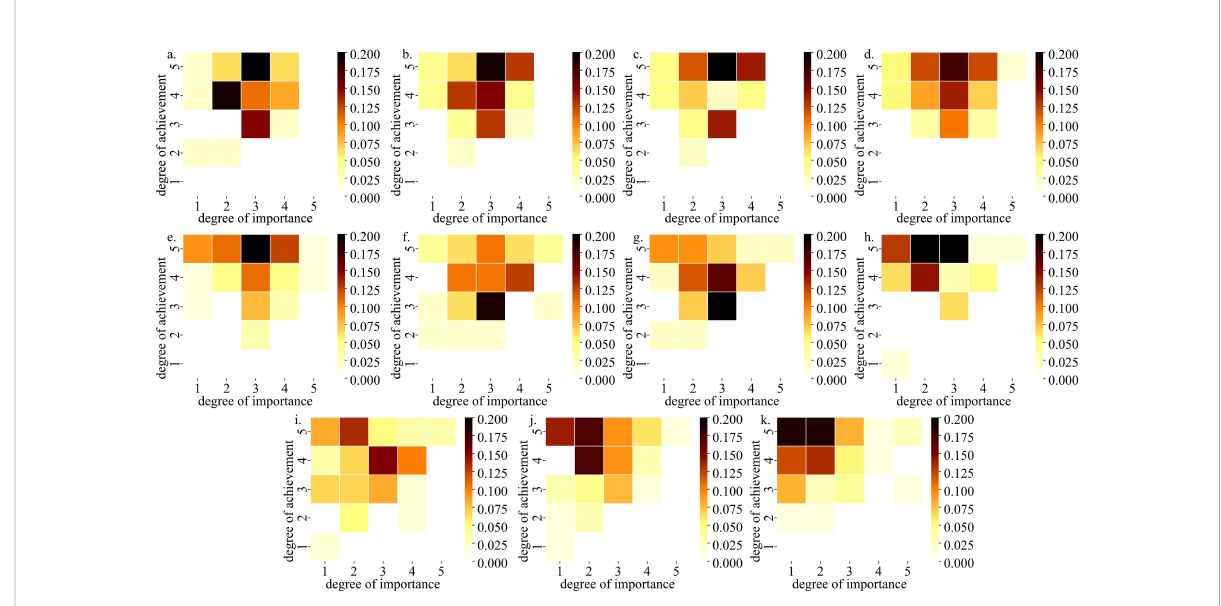
FIGURE 3 Distributions of the combinations of degrees of importance and achievement for each question ( A – K , corresponding to Table 2) regarding marine